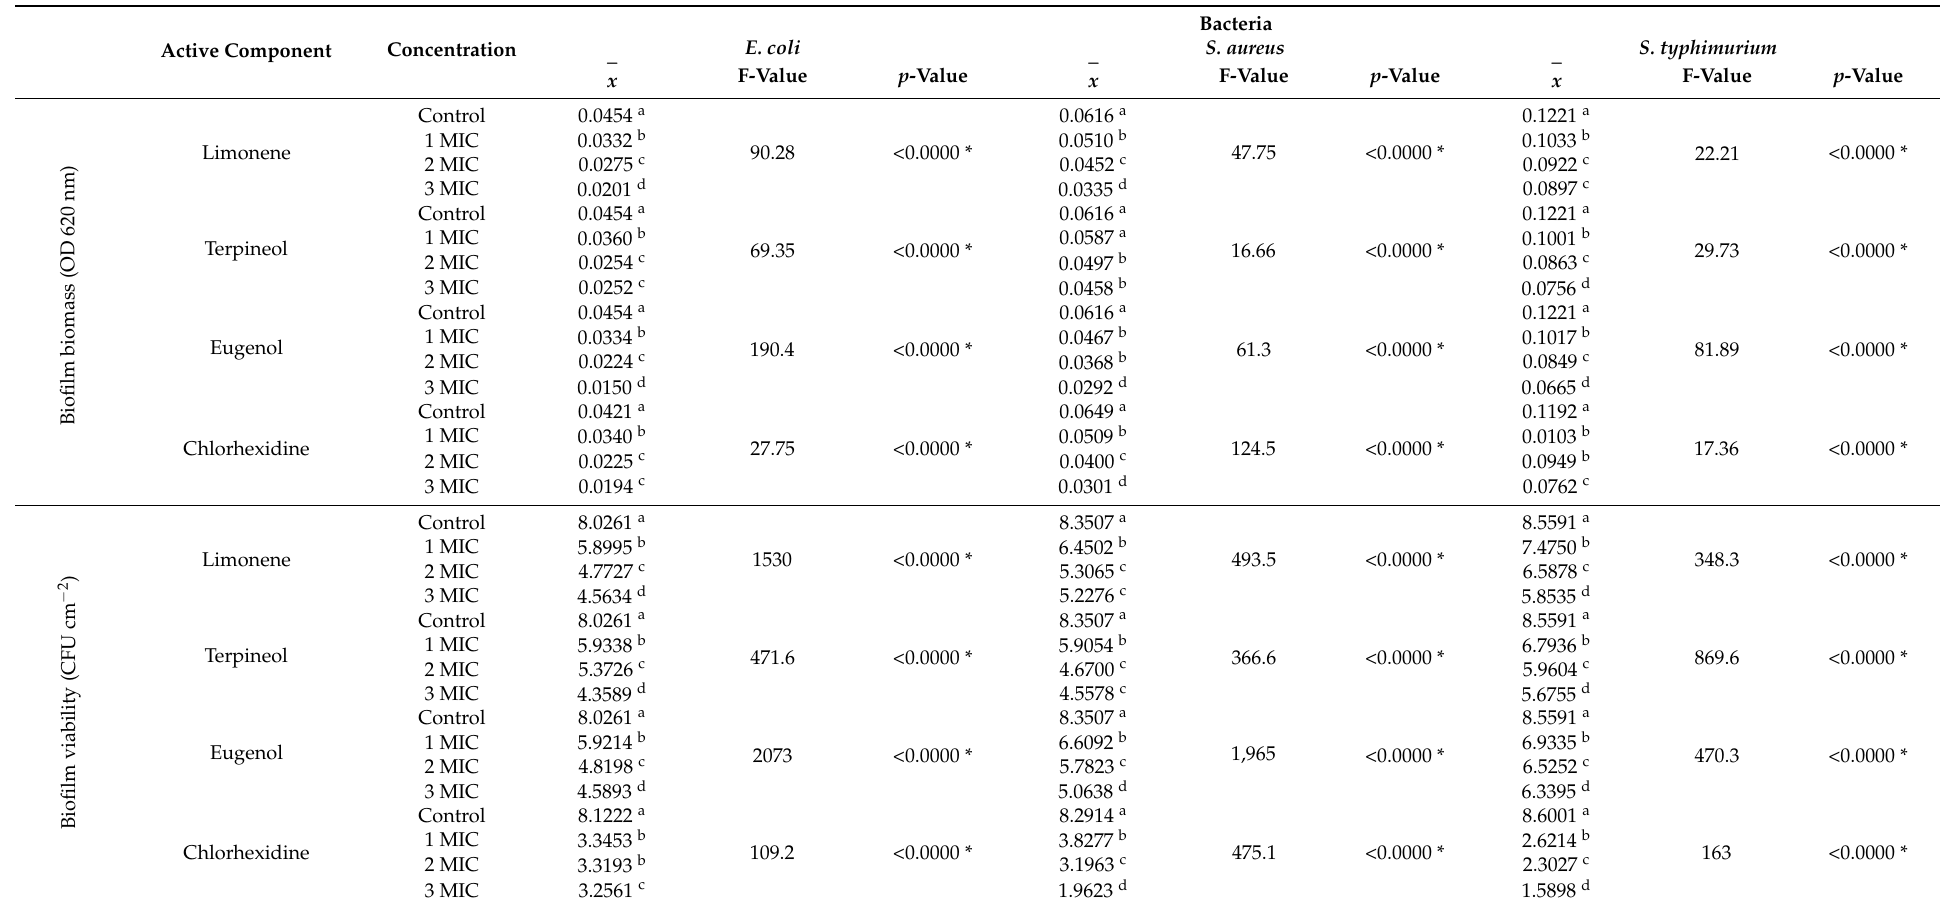
Table 2. Analysis of variance and post hoc Duncan test for biofilm biomass and viability in comparison to limonene, terpineol, eugenol and chlorhexidine